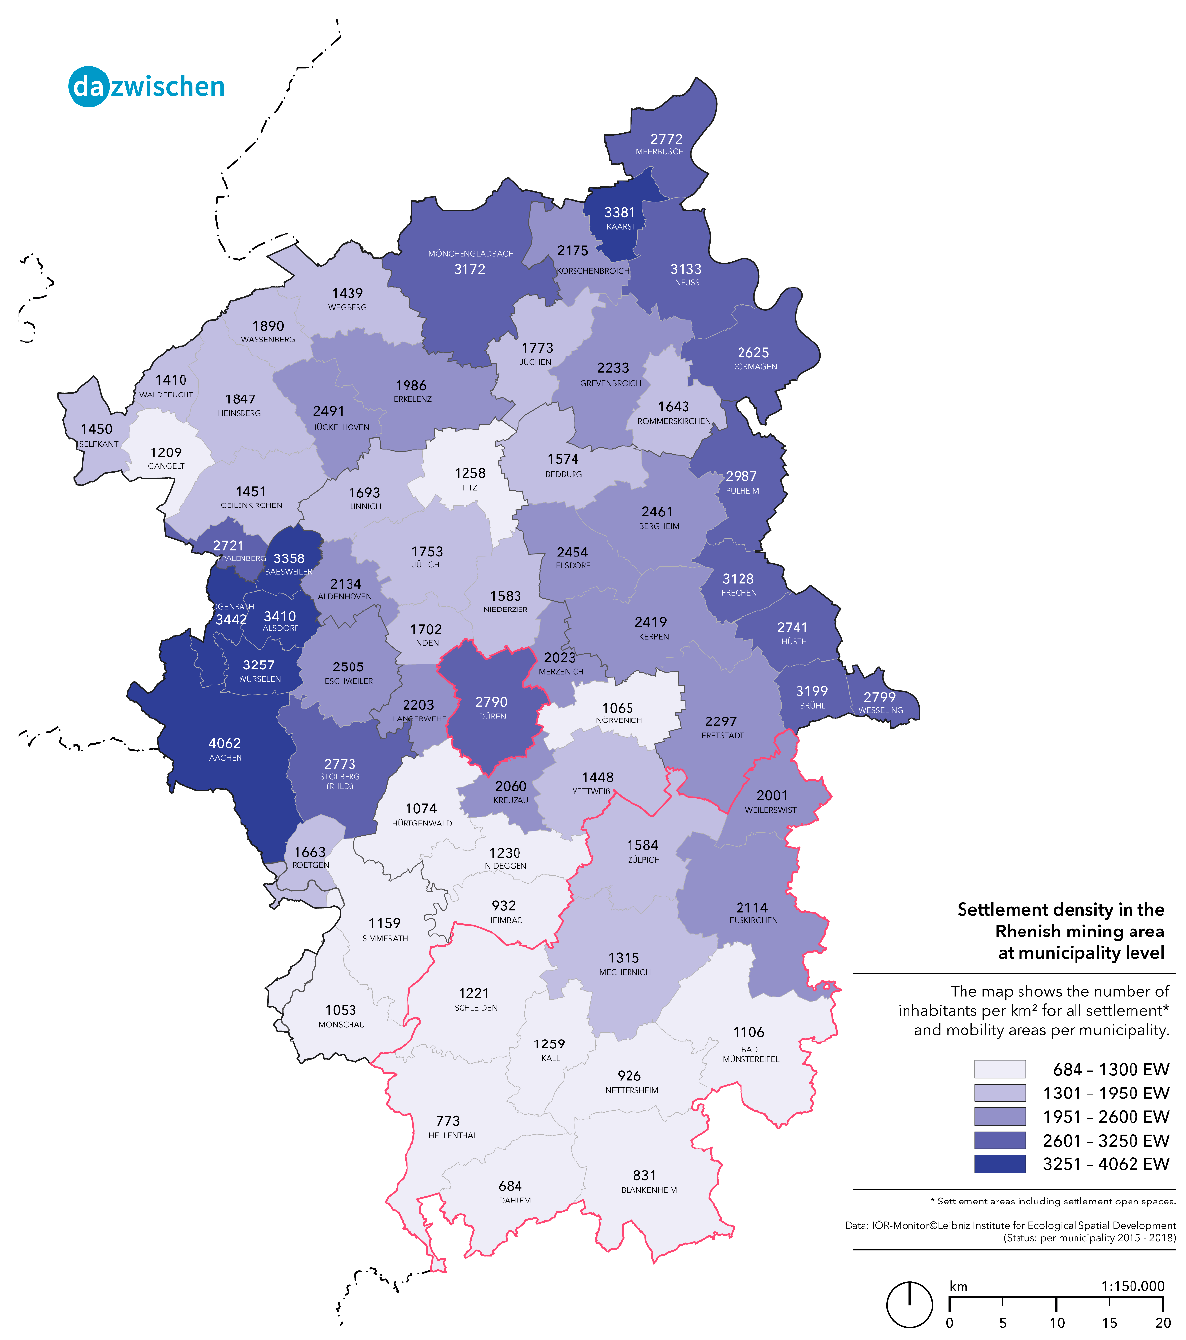
Figure 4. Settlement density in the Rhenish mining area at municipality level. Source: own Figure.